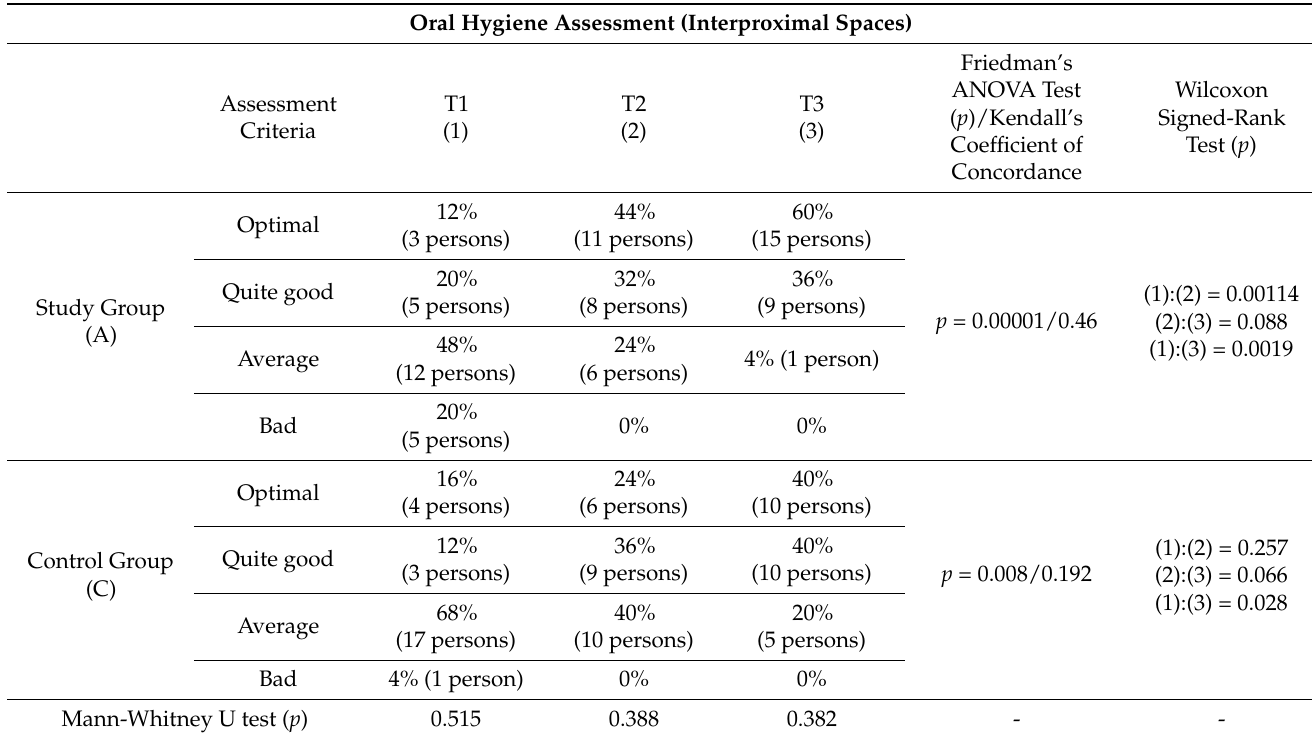
Table 1. Approximal plaque index (API) ranges—assessment for study and control groups. Oral Hygiene Assessment (Interproximal Spaces)